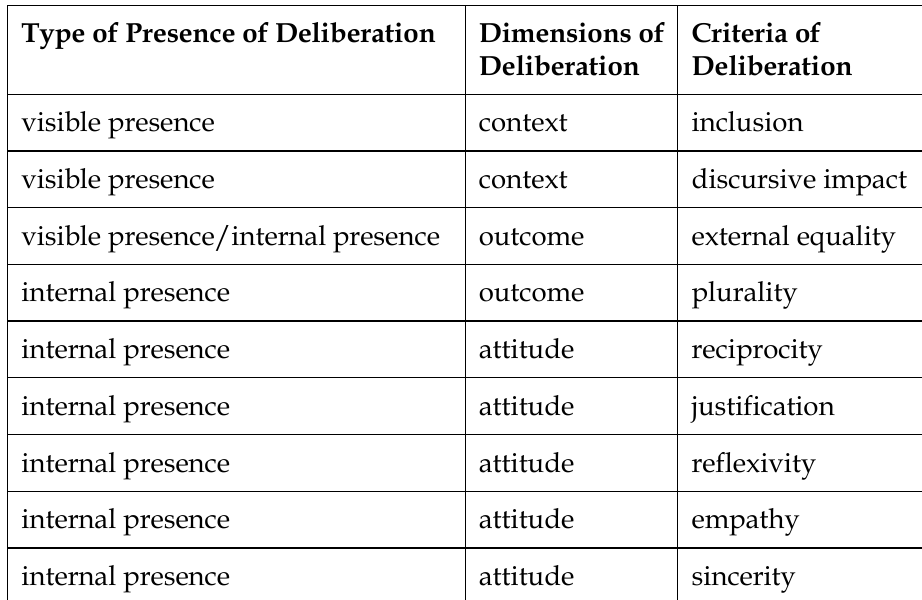
Table 1: The Dimension of Outcome on the IPG and TND Online